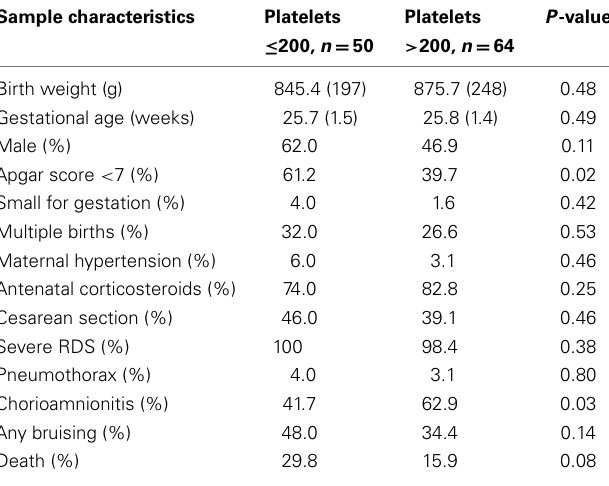
Table 1 | Clinical information for 114 infants between 23 and 28weeks